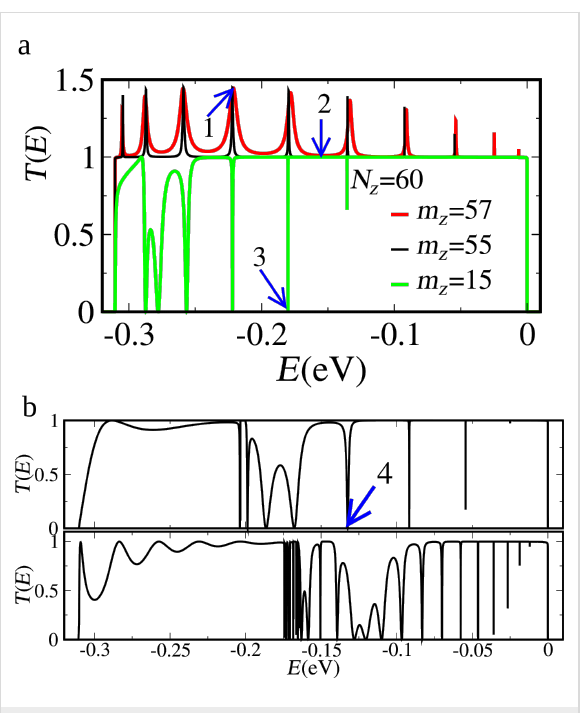
Figure 3: (a) Transmission probabilities, as a function of the Fermi energy, in the energy range of the central band corresponding to nanoribbons with constrictions. Red and green correspond to the cases in Figure 2b, N Z = 60, all with L = 10 and m Z = 57 (shallow constriction) and m Z = 15 (deep constriction), respectively. The black curve corresponds to a constriction with m Z = 55 (intermediate depth). (b) Transmission probabilities for very deep constrictions, m Z = 8 and different lengths: L = 10 (upper panel) and L = 30 (lower panel).